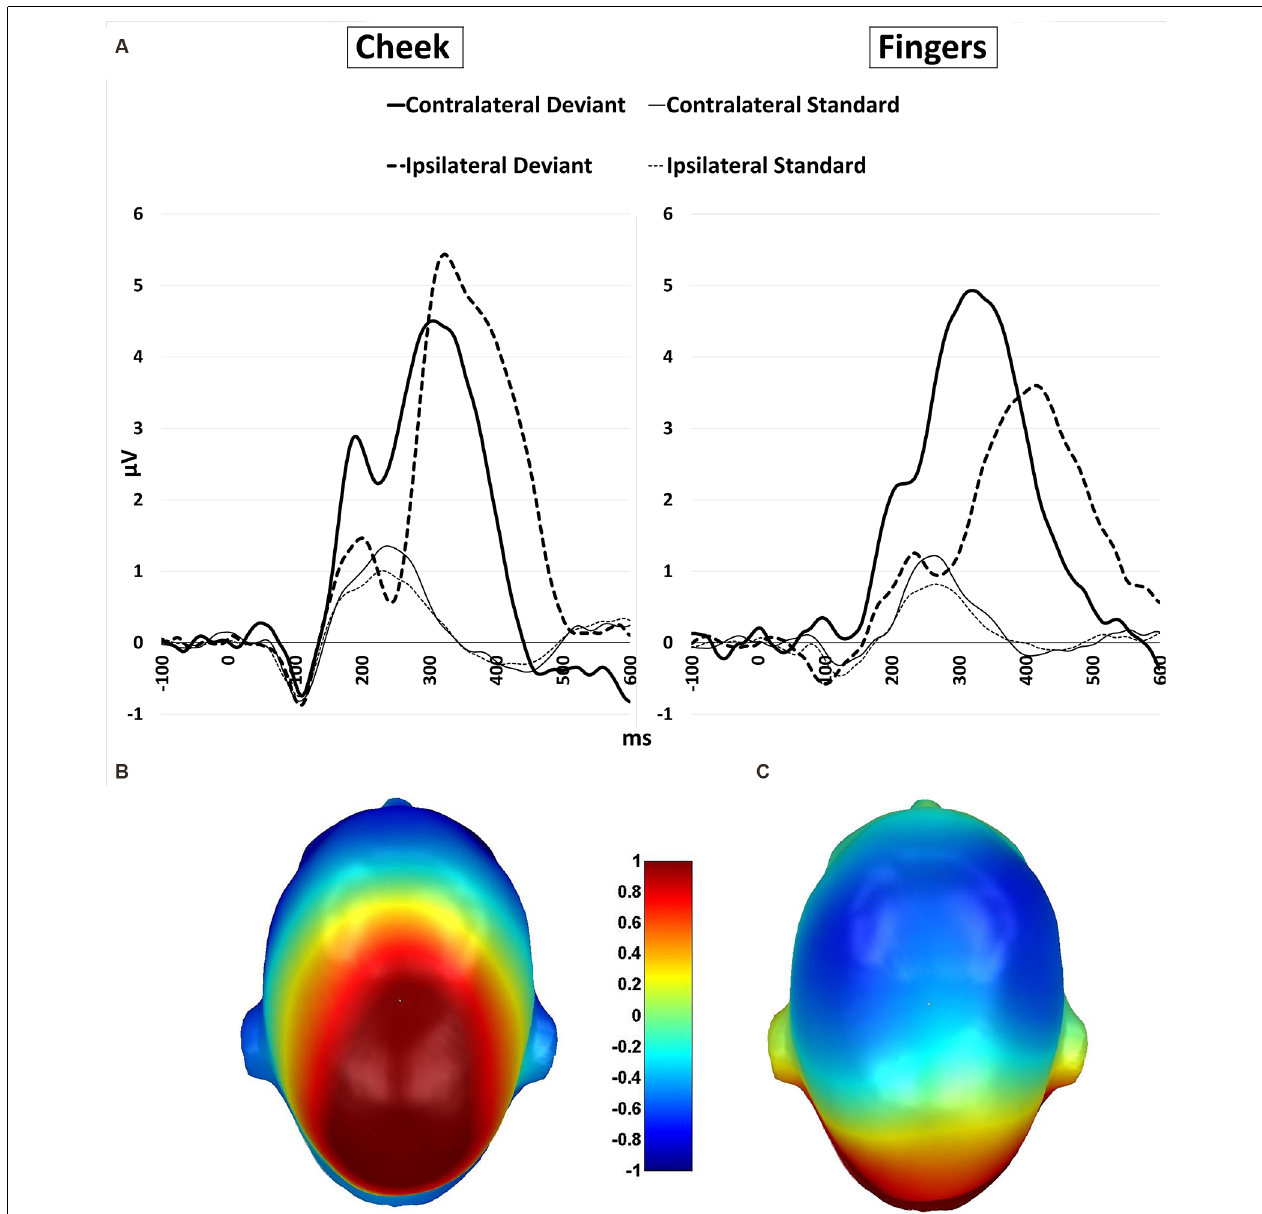
FIGURE 7 | (A) P300 waveforms. Grand-averaged ERP waveforms for central-cluster at the cheek (left) and fingers (right) in response to contralateral presented deviant stimuli (bold black line), ipsilateral presented deviants (bold black dotted), standard stimuli in the contralateral deviant condition (thin black line) and standard stimuli presented in the ipsilateral deviant condition (thin black dotted); (B) topographic difference plot (ipsilateral deviant cheek − contralateral deviant cheek), (C) topographic difference plot (ipsilateral deviant fingers − contralateral deviant fingers). ERP, Event-Related Potentials. the somatosensory cortex leads to higher MMN